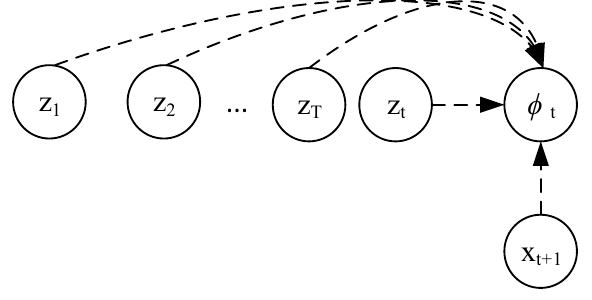
Figure 6. Inference training model.